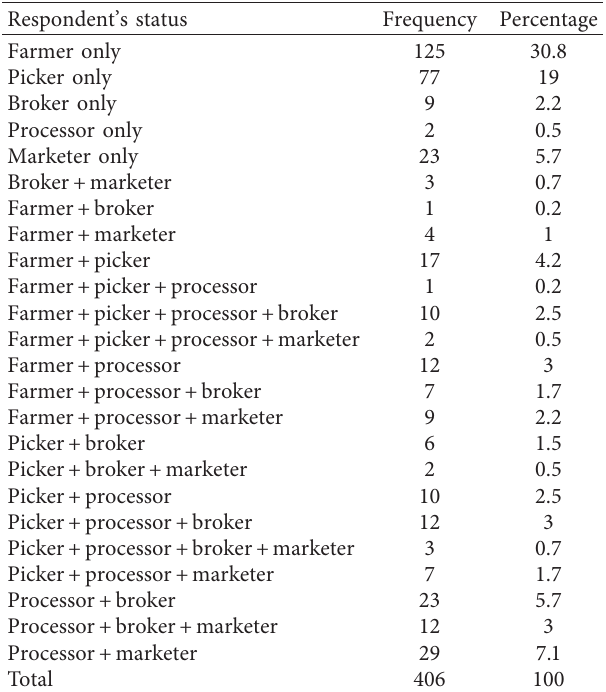
Table 1: Status of respondents in the